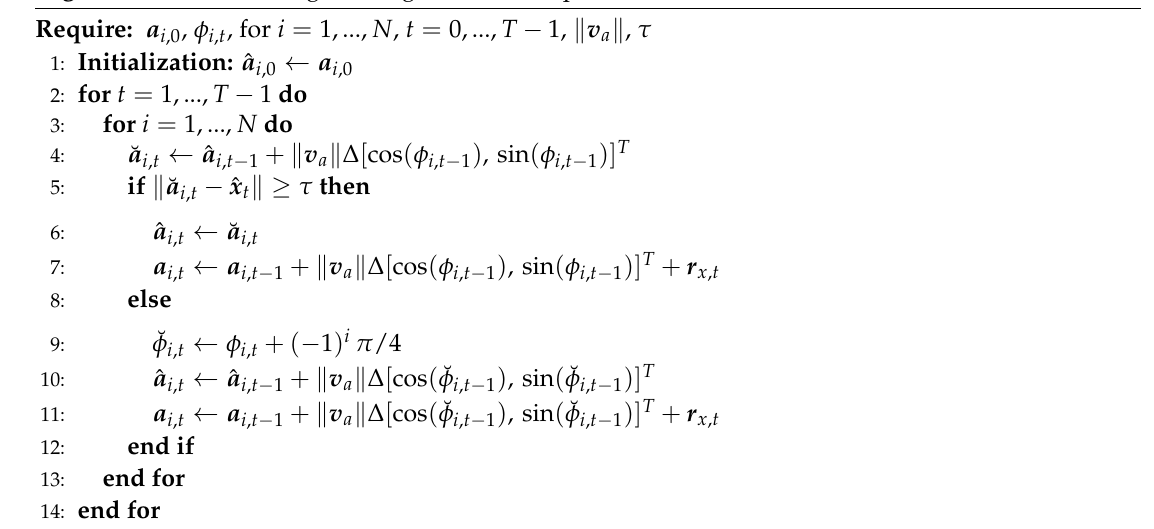
Algorithm 3 Sensor navigation algorithm